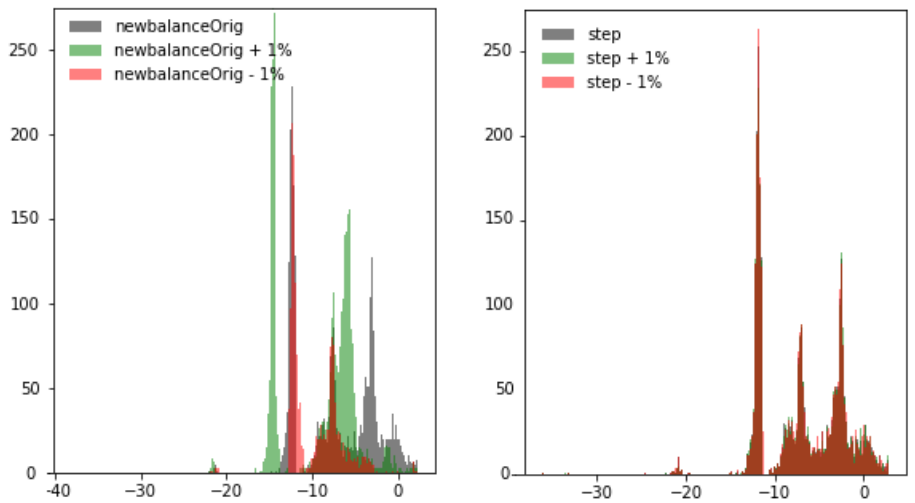
Figure 6. Score distributions obtained in the latent spaces when small variations are applied for PaySim